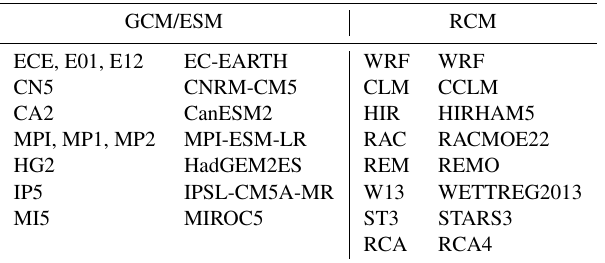
Table 2. Naming convention for the models used.